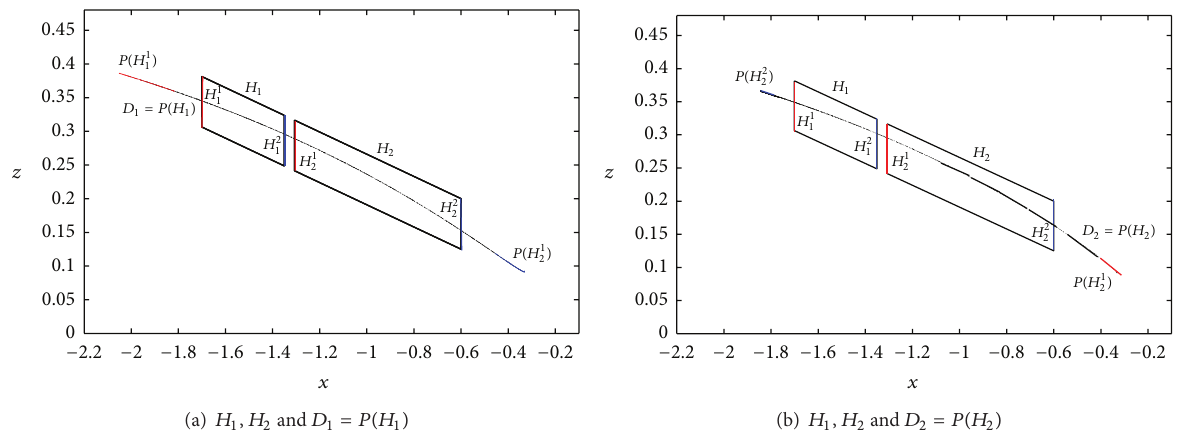
Figure 2: 𝐻 1 , 𝐻 2 and their images 𝐷 1 and 𝐷 2 under 𝑃 .